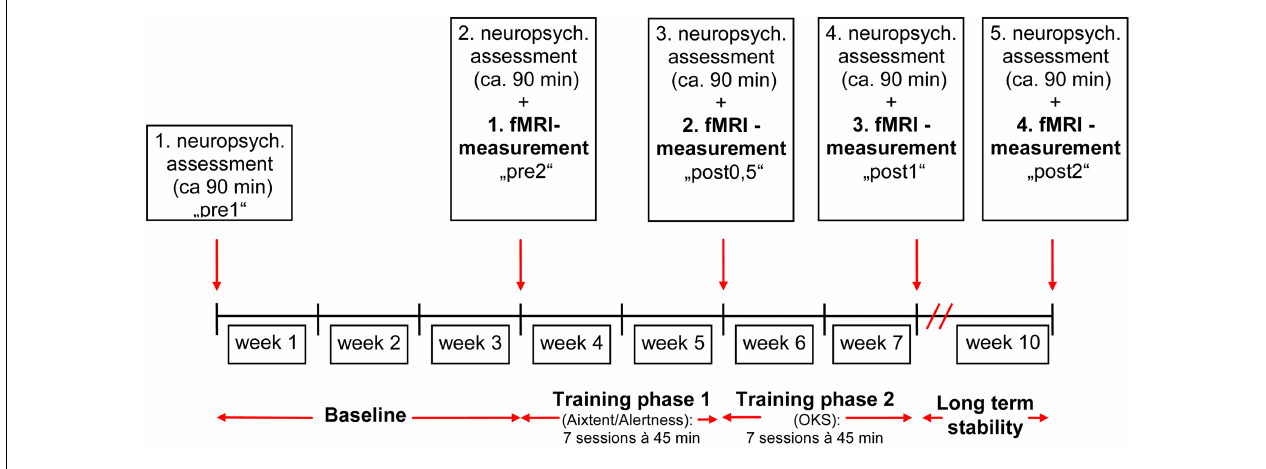
FIGURE 1 |Time schedule for the combined training alertness-OKS